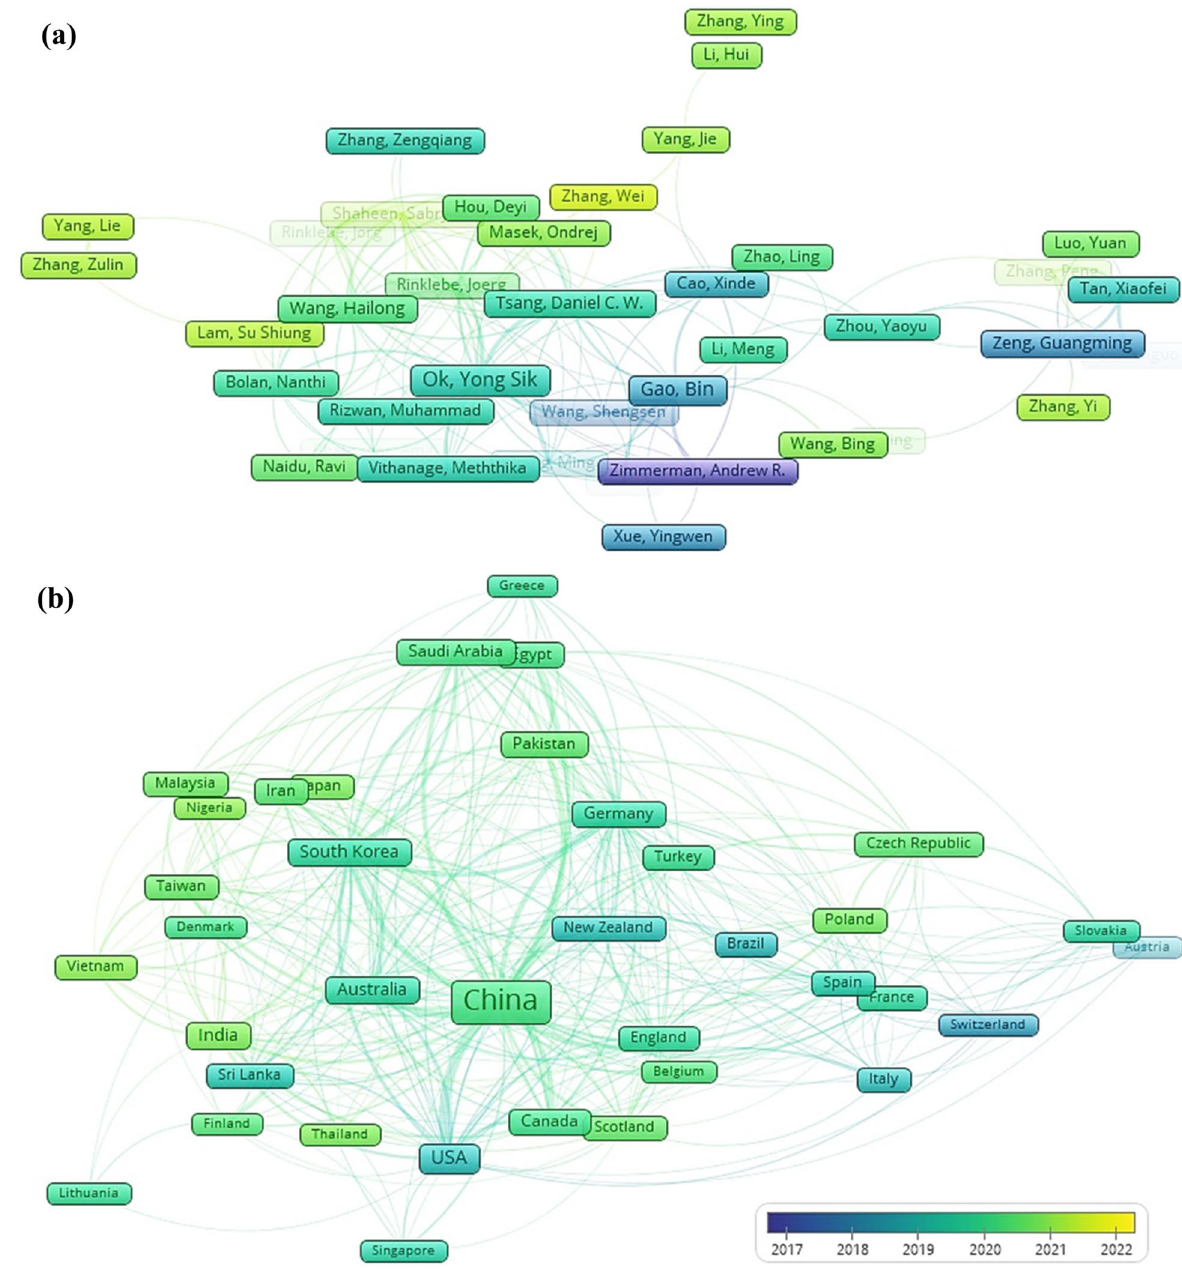
Fig. 9 Bibliometric network for modified biochars between a authors and b countries for minimum 10 document